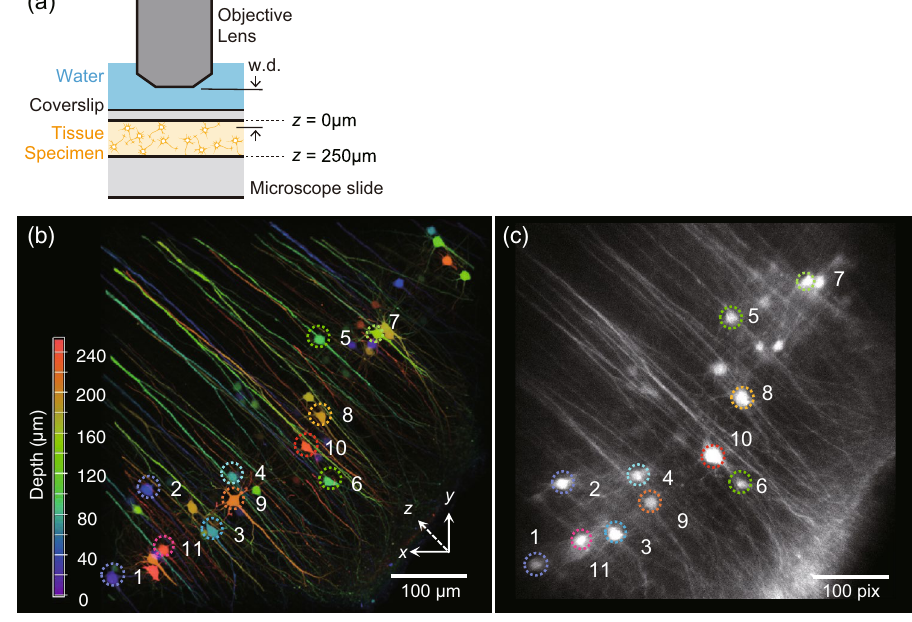
Figure 3. Comparison between z- stacked Gaussian beam scanned image and Bessel beam scanned image of a Sca l eA2 cleared thy1-YFP-H mouse brain slice. ( a ) Relative configurations of the objective lens and the fixed slice. ( b ) 3D reconstructed image from Maximum intensity projection of a 250 µm thick z- stack image of neurons (color-coded by depth) in the sensory cortex measured by Gaussian beam scanning. The neurons were serially numbered in accordance with the z position started from the surface of the brain slice. ( c ) A xy image of the same field of view in ( b ) at the focus, 60 µm apart from the slice surface, was collected by scanning a Bessel beam using the light-needle creating device. The same neurons were selected and numbered as in ( b ). The scale bar along an image was shown as their